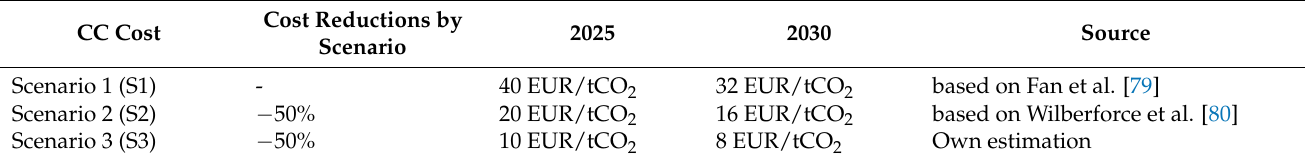
Table 5. Scenarios based on different carbon capture cost-levels for 2025 and